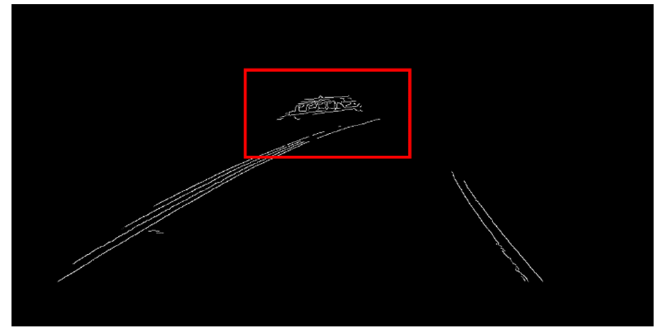
Figure 15. Fake edges caused by parapets.